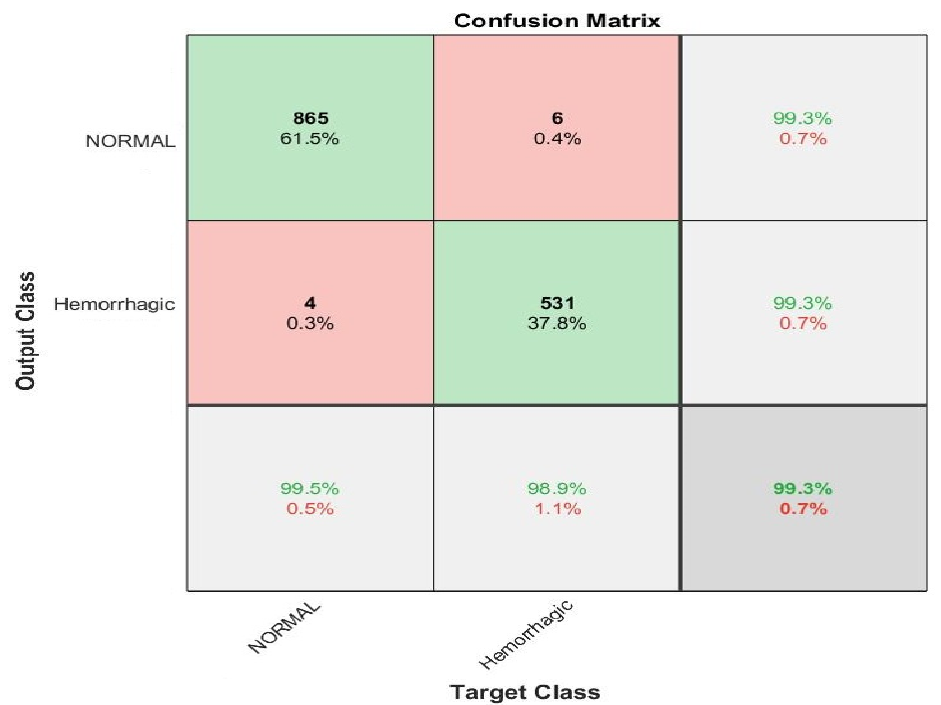
Figure 21. ANN’s confusion matrix based on features fused between AlexNet and GLCM and LBP.